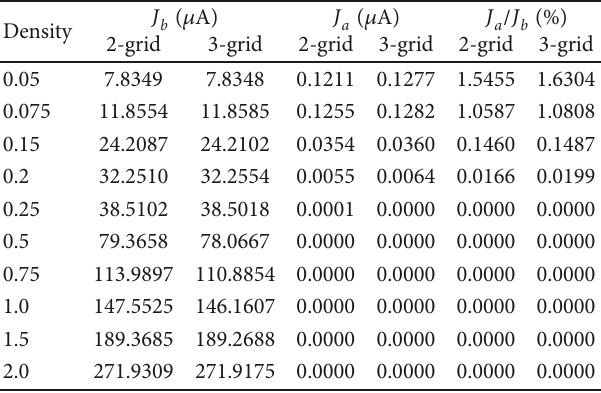
Table 4: Ratio of the impingement current of the accelerator grid to the beam current without CEX ions.